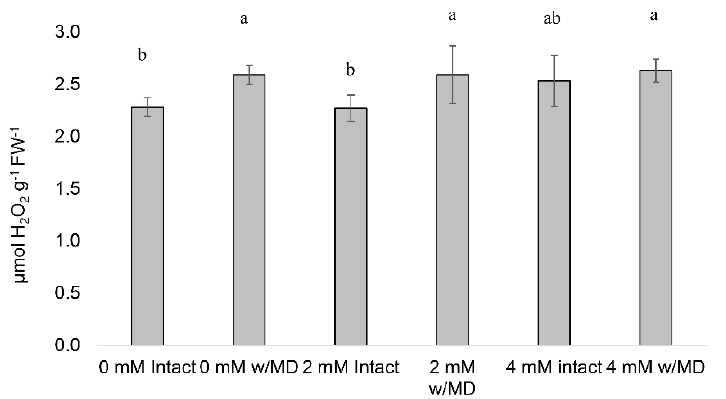
Figure 8 . Hydrogen peroxide (H 2 O 2 ) in Annona emarginata plants submitted to the treatments: 0 mM Ca 2+ without mechanical damage (intact), 0 mM Ca 2+ with mechanical damage (w/MD), 2 mM Ca 2+ intact, 2 mM Ca 2+ w/MD, 4 mM Ca 2+ intact, and 4 mM Ca 2+ w/MD. Values correspond to means ± SE ( n = 20). Lowercase letters indicate differences between treatments .